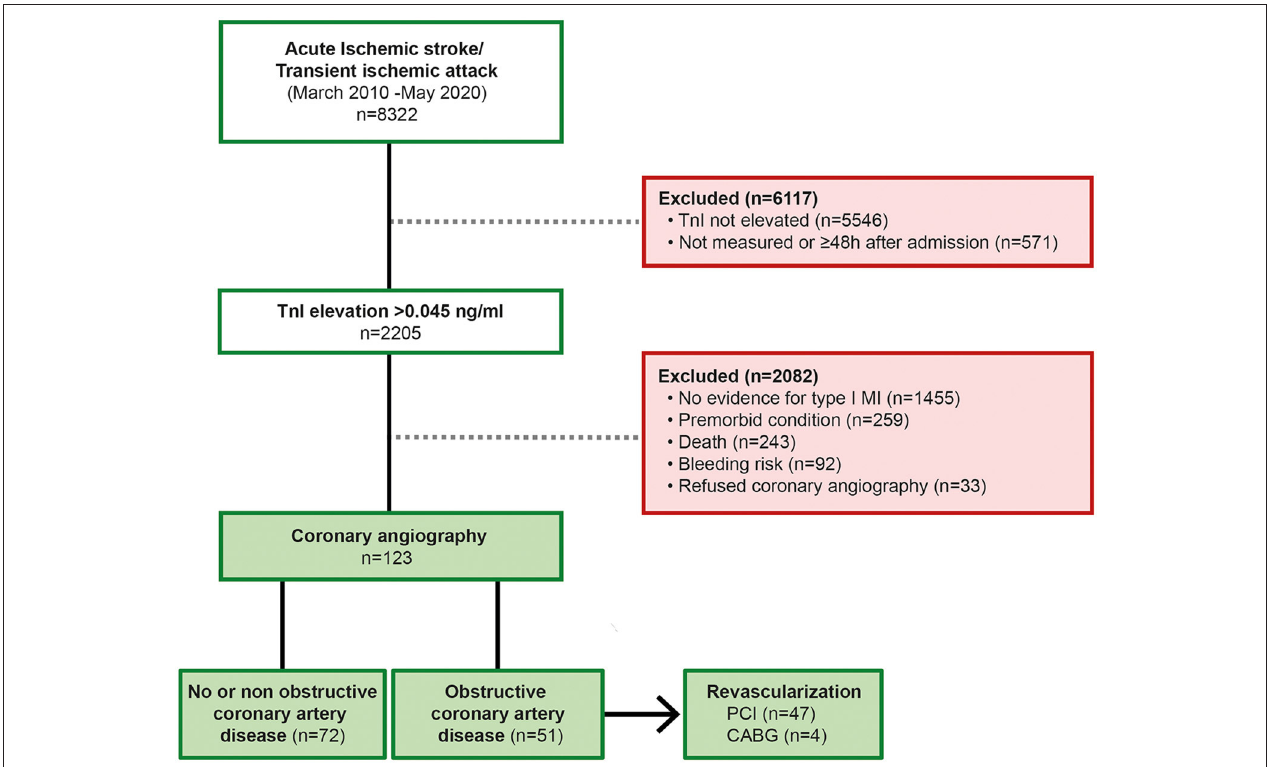
FIGURE 1 | Flowchart illustrating the enrollment process. Obstructive CAD was defined as hemodynamically relevant stenosis, either by visual evaluation ( ≥ 80%) or by FFR pressure wire measurement ( < 0.80) or iwFR ( < 0.89); TnI, Troponin I; PCI, percutaneous coronary intervention; CABG, coronary artery bypass graft.